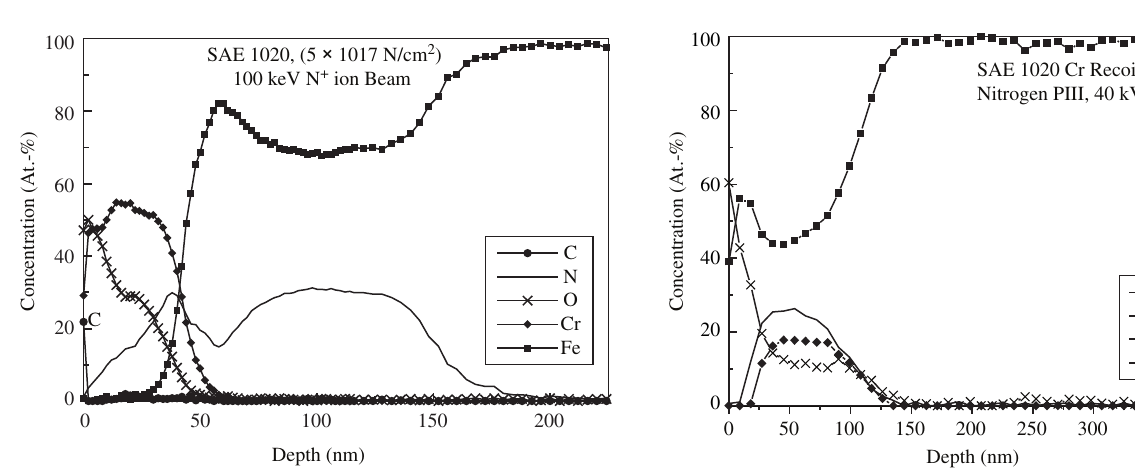
Figure 2. Theoretical depth profile of Cr atoms in SAE 1020, after Nitrogen recoil, a) at 40 kV (PIII); and b) 100 keV (IB), beyond the 50 nm original Cr film.